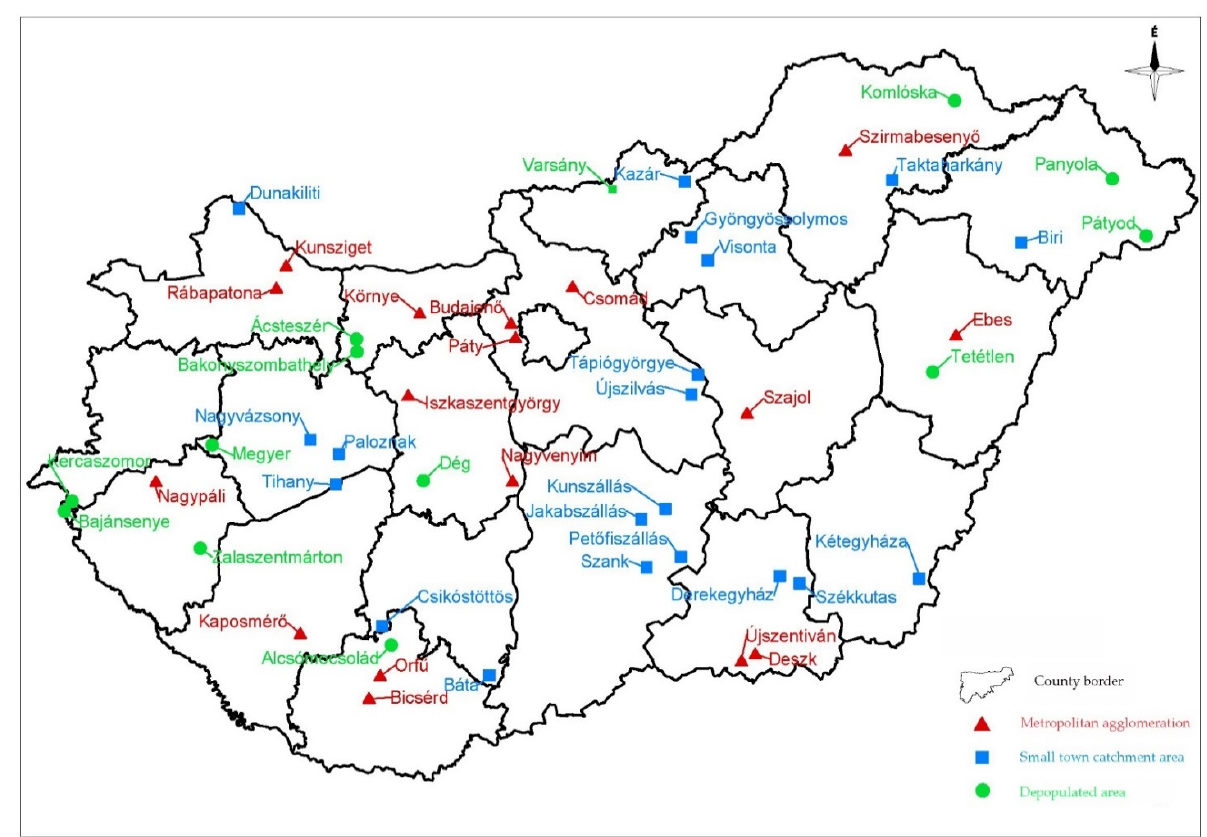
Figure 3. Location of sample settlements by groups of settlements.